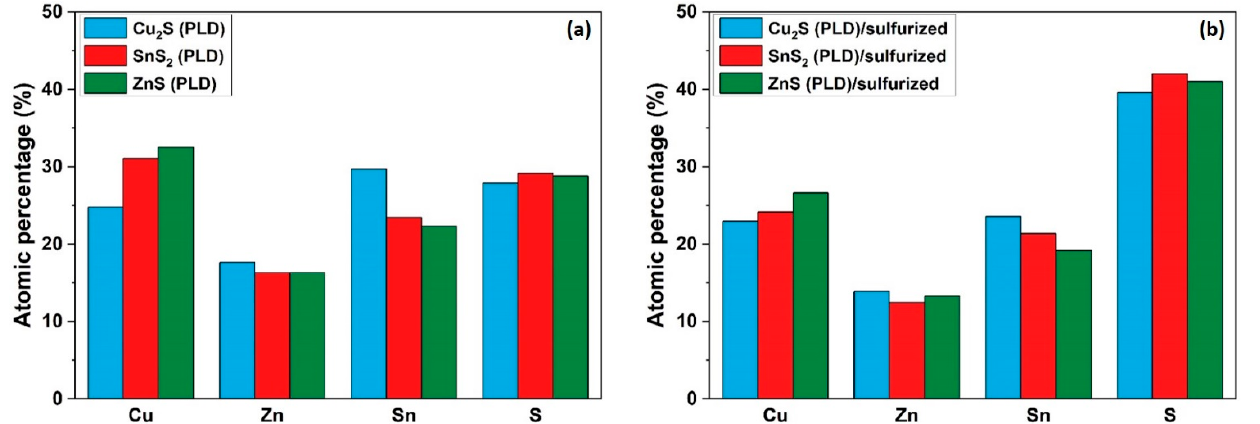
Figure 5. Average atomic ratios of Cu, Zn, Sn and S in the samples obtained in the hybrid MSPLD deposition system: ( a ) as-deposited and ( b ) sulfurized.